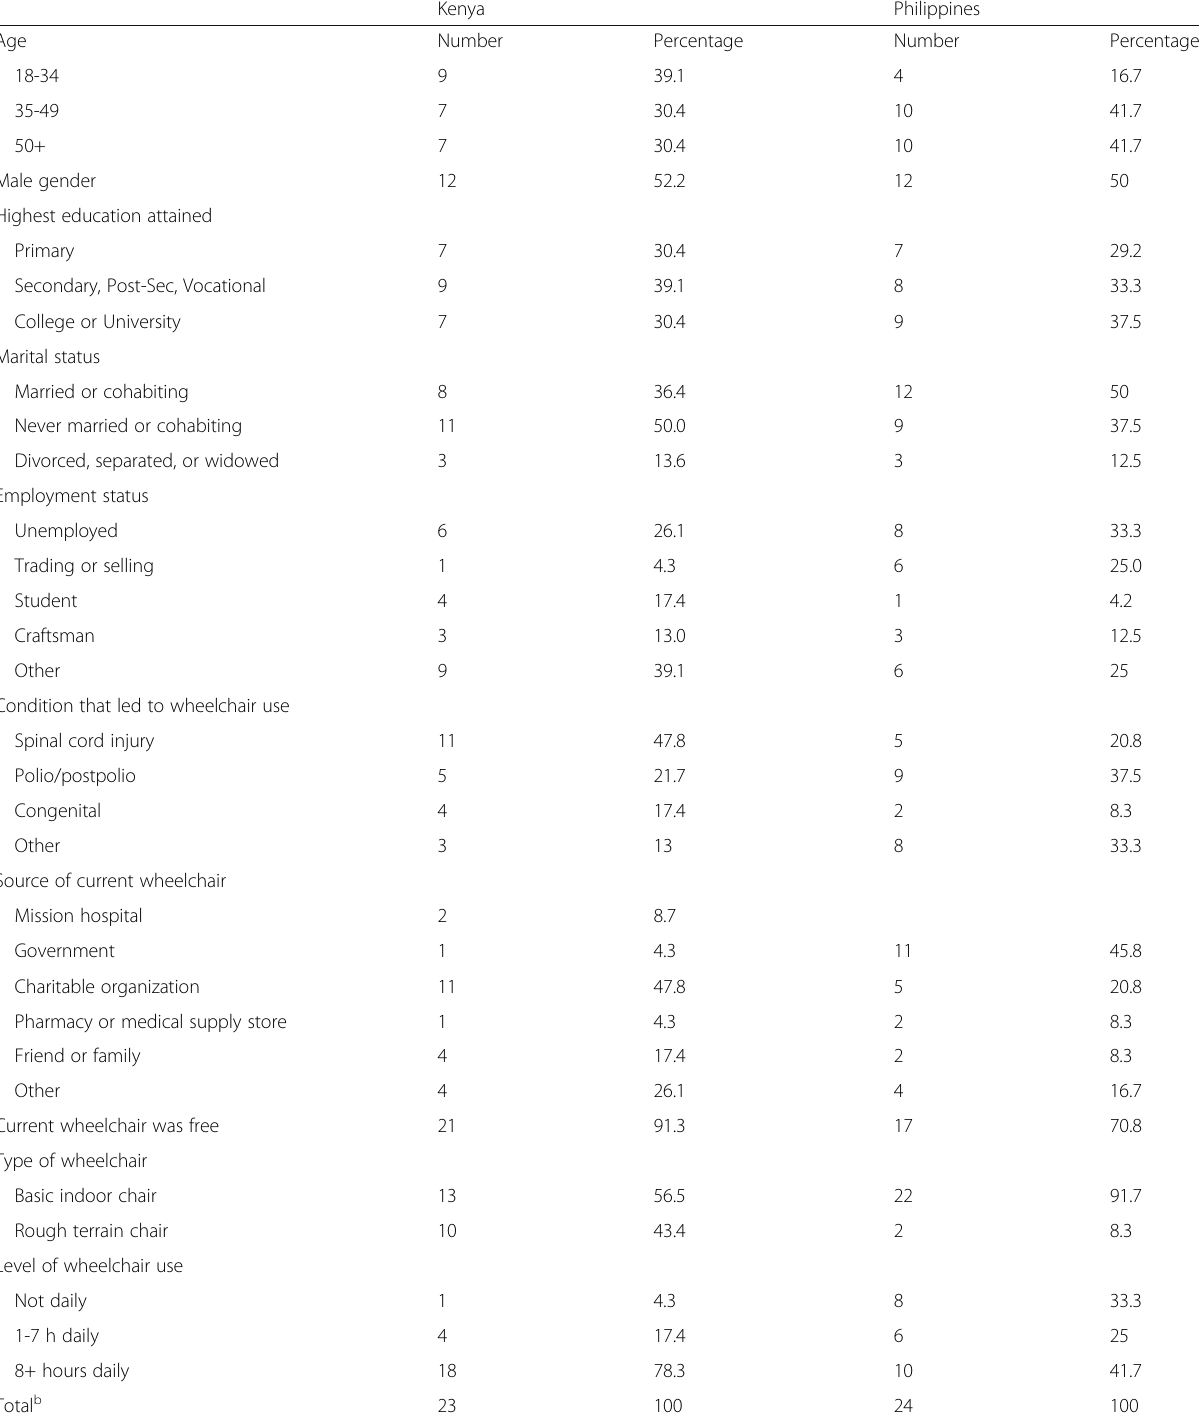
Table 2 Characteristics of qualitative interview participants and their current wheelchairs, in Kenya and Philippines, based on questionnaire